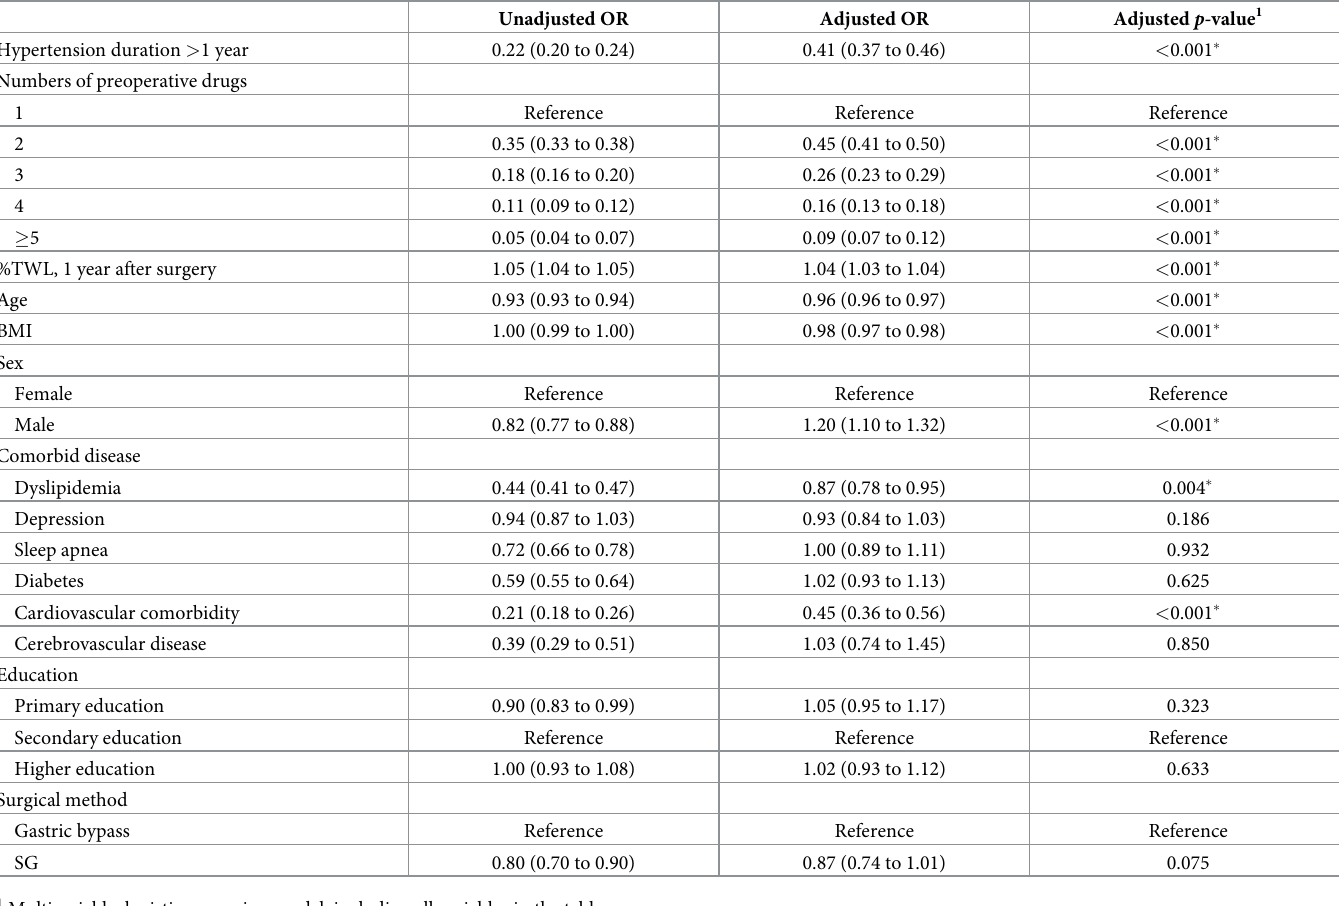
Table 2. Chance of reaching hypertension remission 2 years after